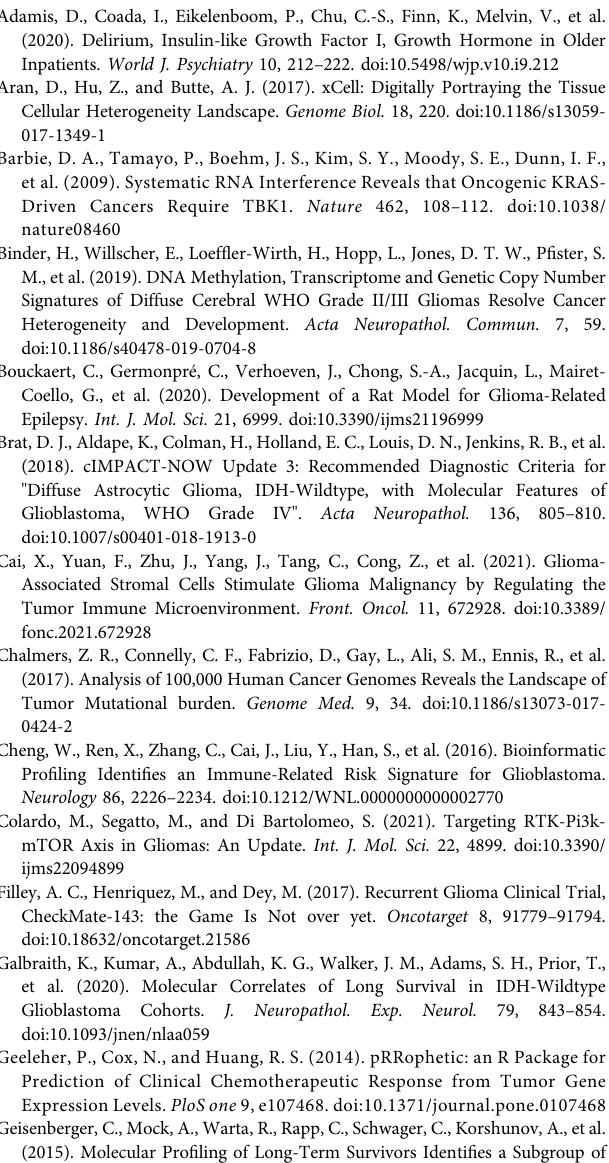
Supplementary Figure S10 | the CNAs of the target gene. (A) Top 20 CNA genes; (B) The CNAs of target genes. Supplementary Figure S11 | Knockdown of PSMB8 suppressed the proliferation, migration, invasion, and increased cell apoptosis of U251 and LN229 cells in vitro. (A) Western blot analysis to examine the ef fi ciency of the PSMB8 knockdown. (B) EdU staining to assess proliferation ability. (C) Clonogenic assays to assess colony-forming abilities. (D and E) Transwell assays to detect the migration and invasive capacities. (F) Flow cytometry to analyze the apoptosis of U251 and LN229 cells. (G) Relative quantitation of PSMB8 protein expression levels in ASO-treated U251 and LN229 cells. (H) PSMB8 expression in glioma tissues and normal tissues. Magni fi cation, × 200 (B, D, and E) . Scale bar, 100 μ m (B, D, and E) . * p < 0.05; ** p < 0.001; *** p < 0.001; **** p < 0.0001. Data are shown as mean ± SD at least three independent